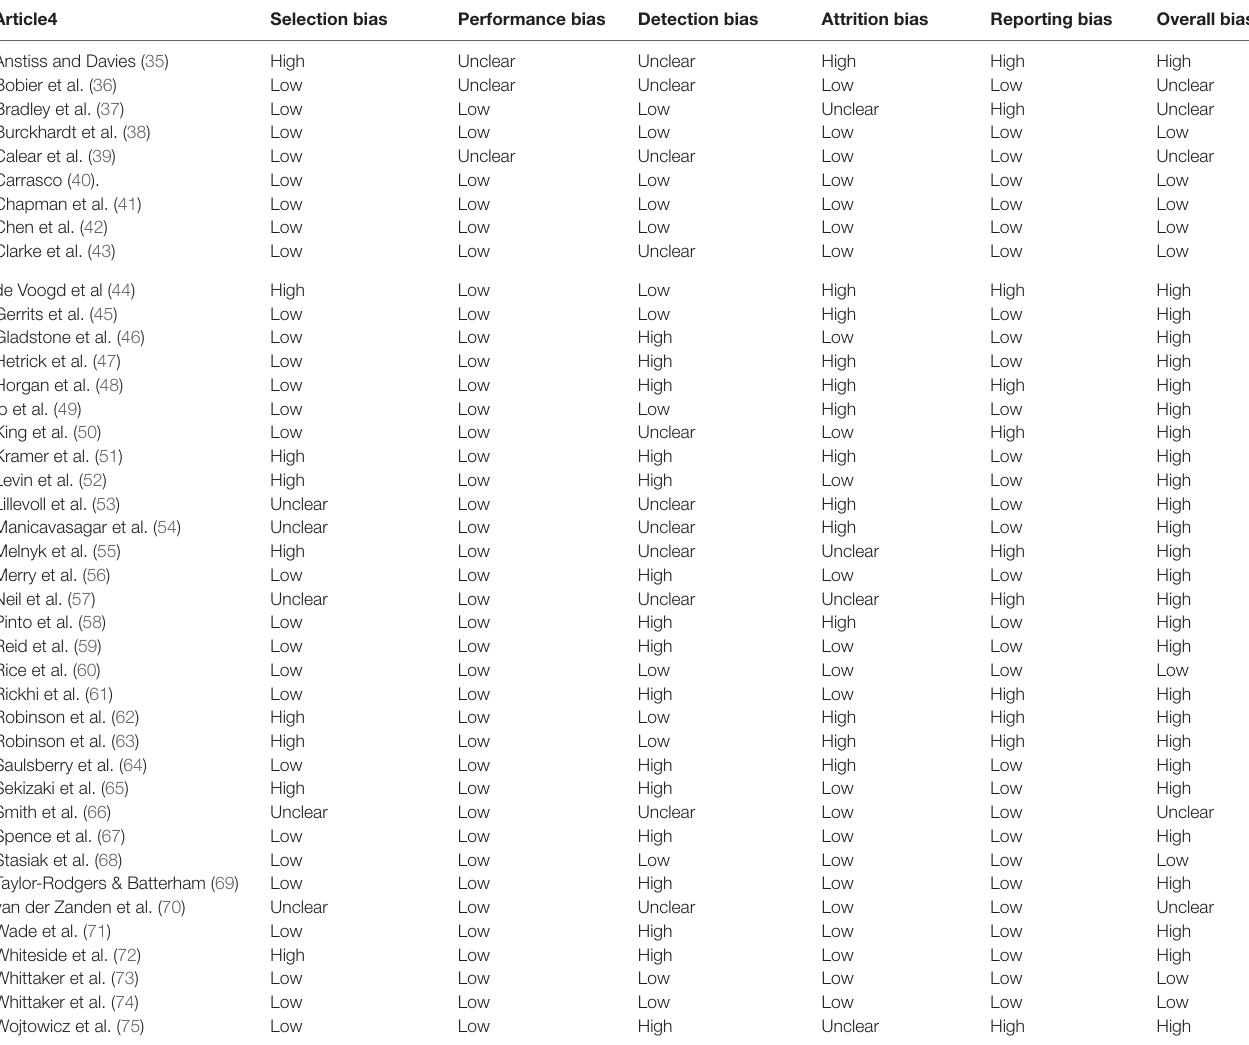
TABLE 4 | Assessment of bias across all